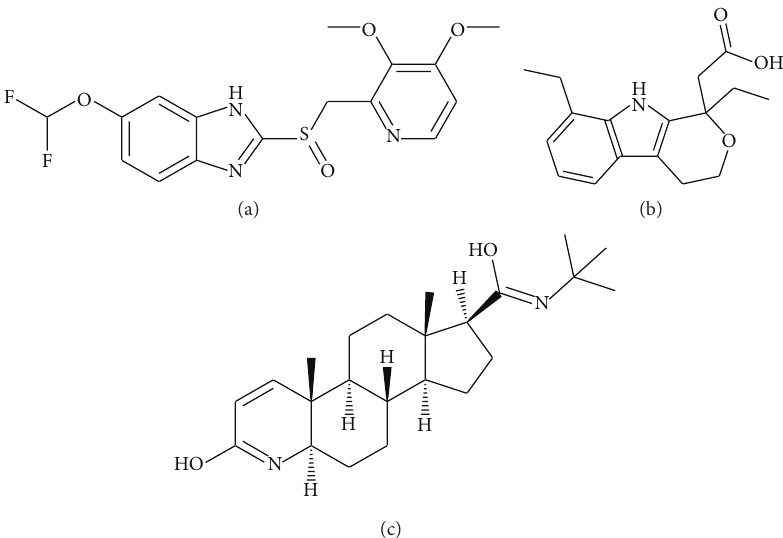
Figure 1: Chemical structures of (a) pantoprazole, (b) etodolac, and (c) finasteride